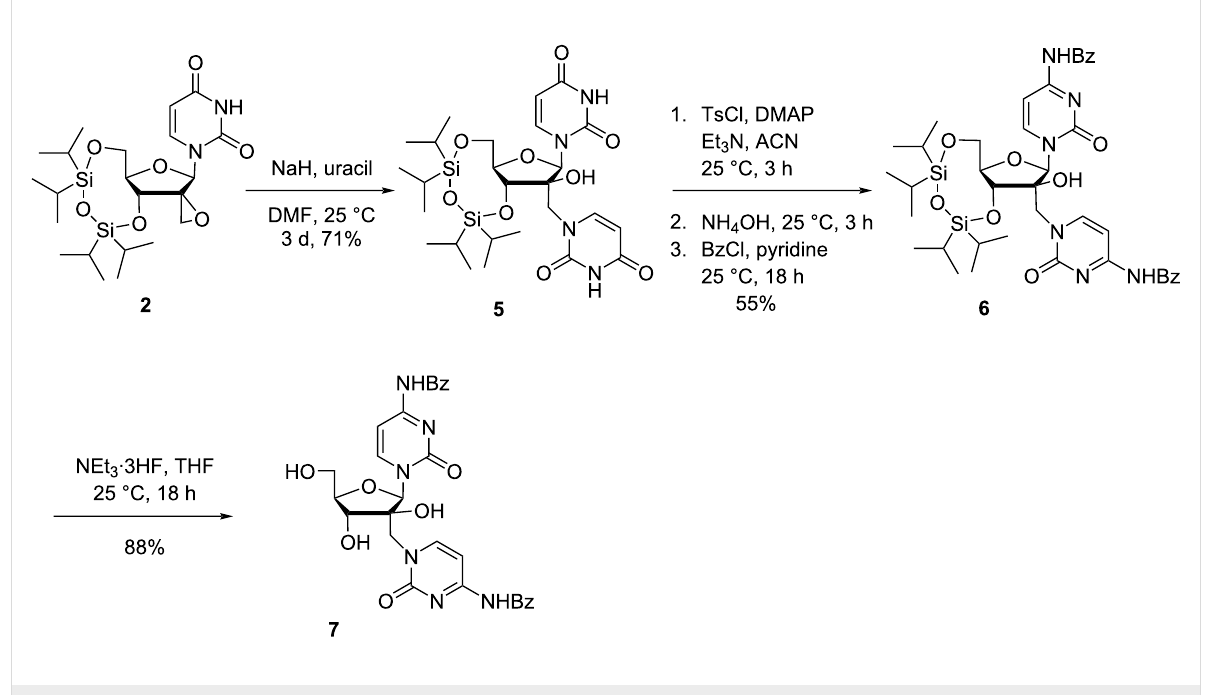
N 3 -benzoyluridine ( 10 ) the double-headed nucleoside 11 was obtained in 67% yield (Scheme 3)